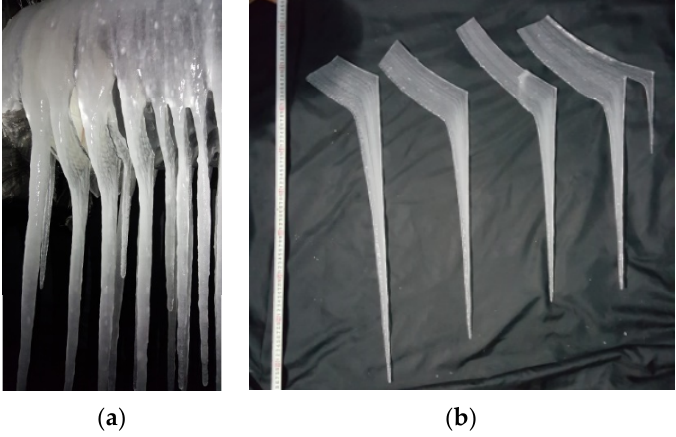
Figure 15. Some details of the icicle: ( a ) D = 200 mm, and ( b ) D = 1000 mm.